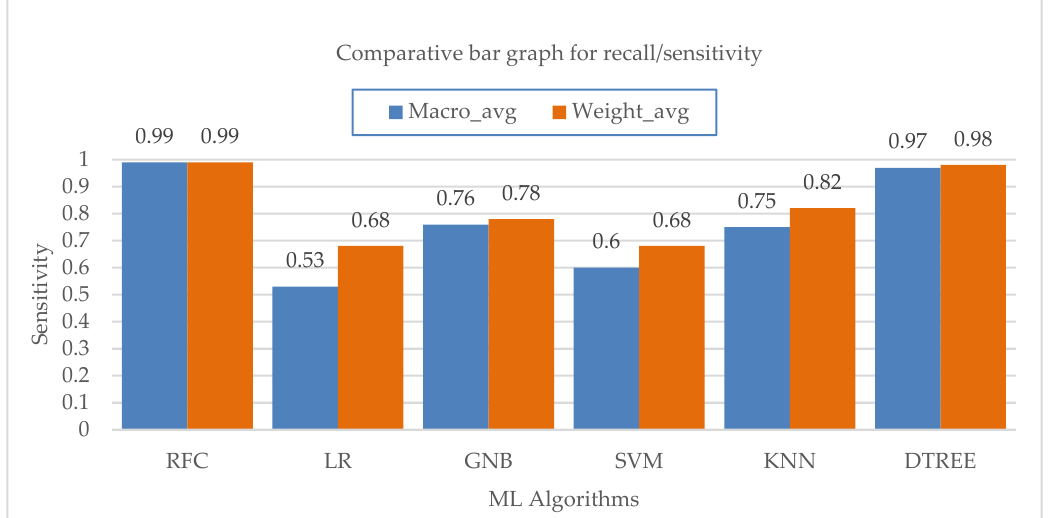
Figure 9. Bar chart visualization of sensitivity comparison among different ML algorithms.